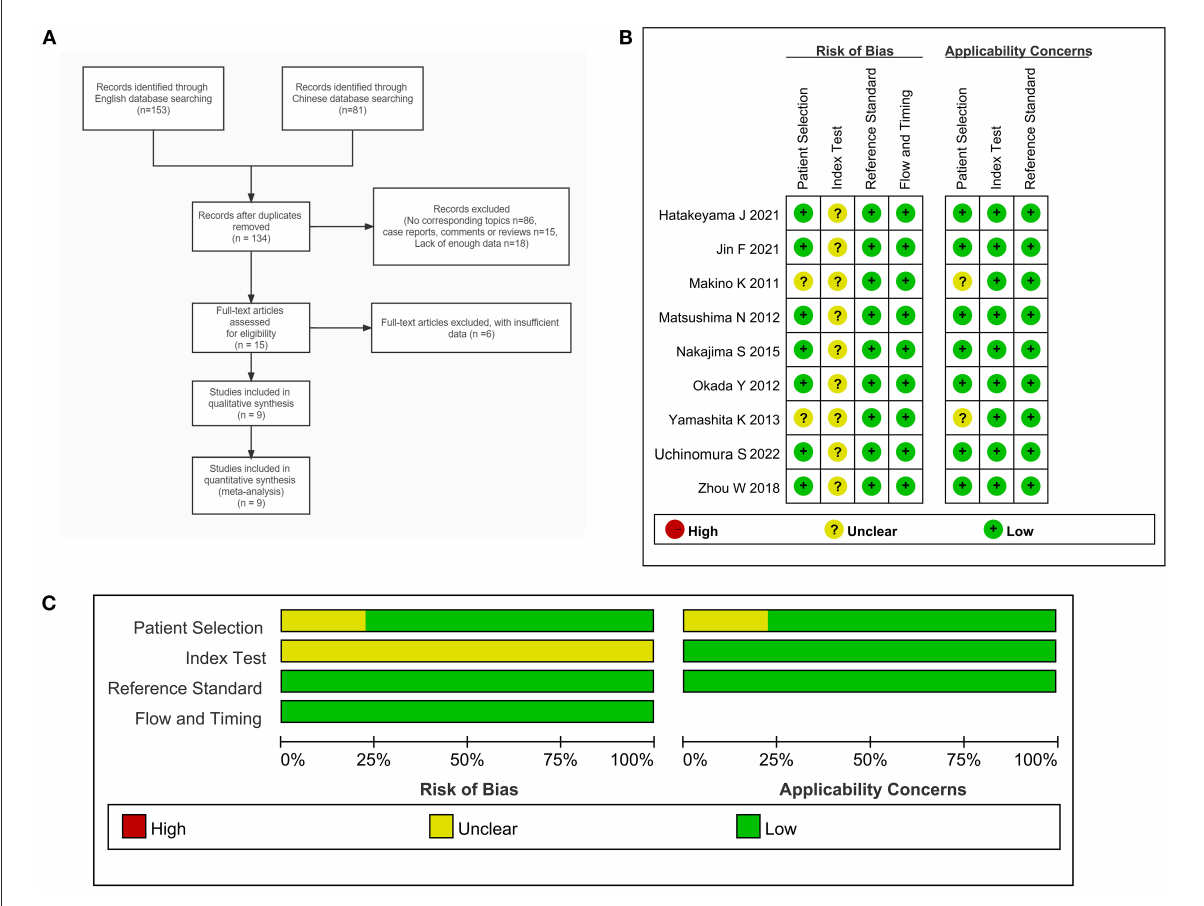
FIGURE1 (A) Flow chart of the inclusion and exclusion of literature in this study. (B) Document quality evaluation chart. (C) Methodological qualitative analysis of the included